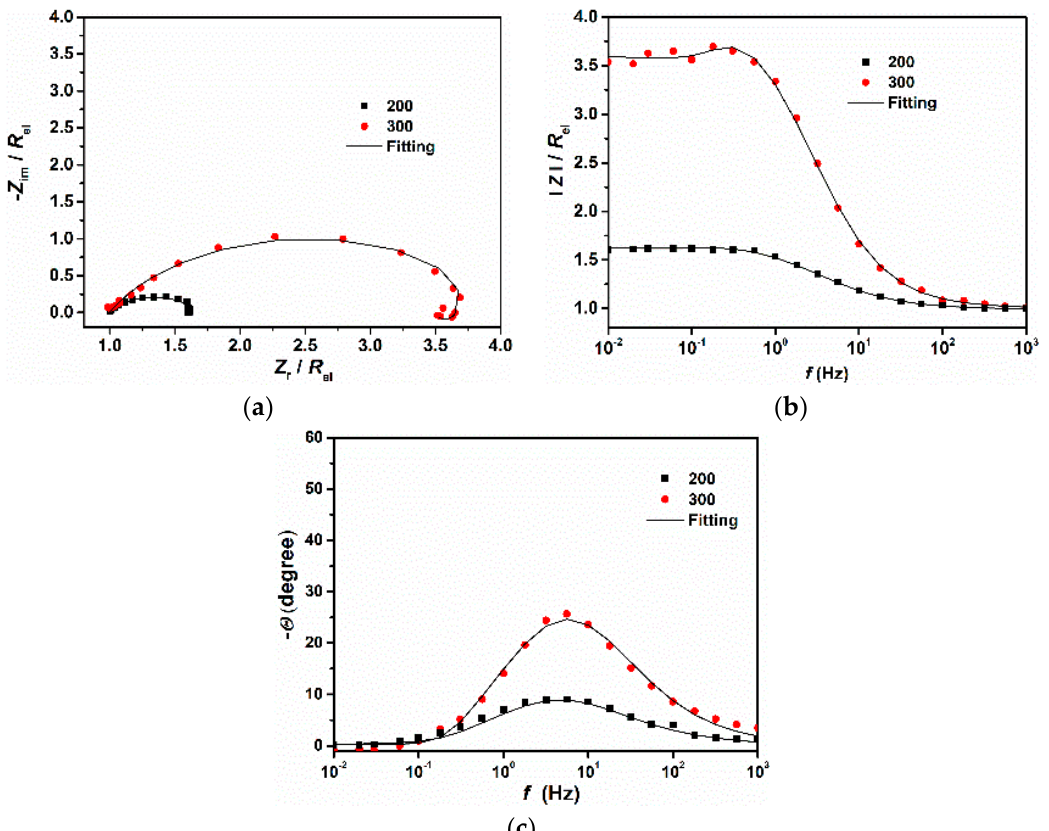
Figure 5. EIS plots comparing the two steels after 24 h of immersion and after the IR drop correction in the tested solution. ( a ) Nyquist, ( b ) Bode and ( c ) Phase angle. Table 4. Electrochemical impedance parameters of the two steels in the tested solution after the IR drop correction. Sample